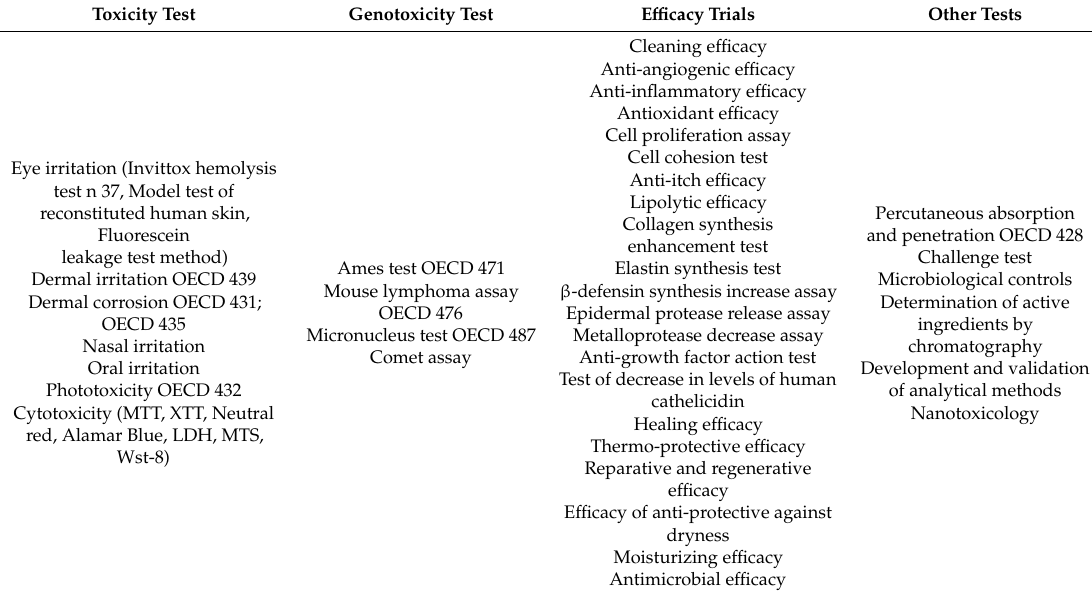
Table 1. Pharmacovigilance test in pharmacocosmetics 1 .